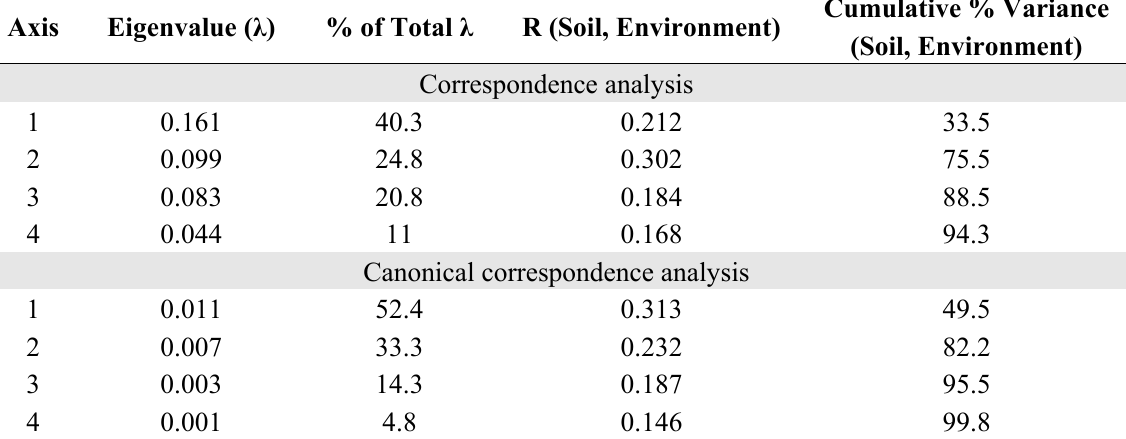
Table 4. Variance accounted for by the first four axes of correspondence analysis (CA) and canonical correspondence analysis (CCA). (Sum total eigen value for CA is 0.4 and for CCA is